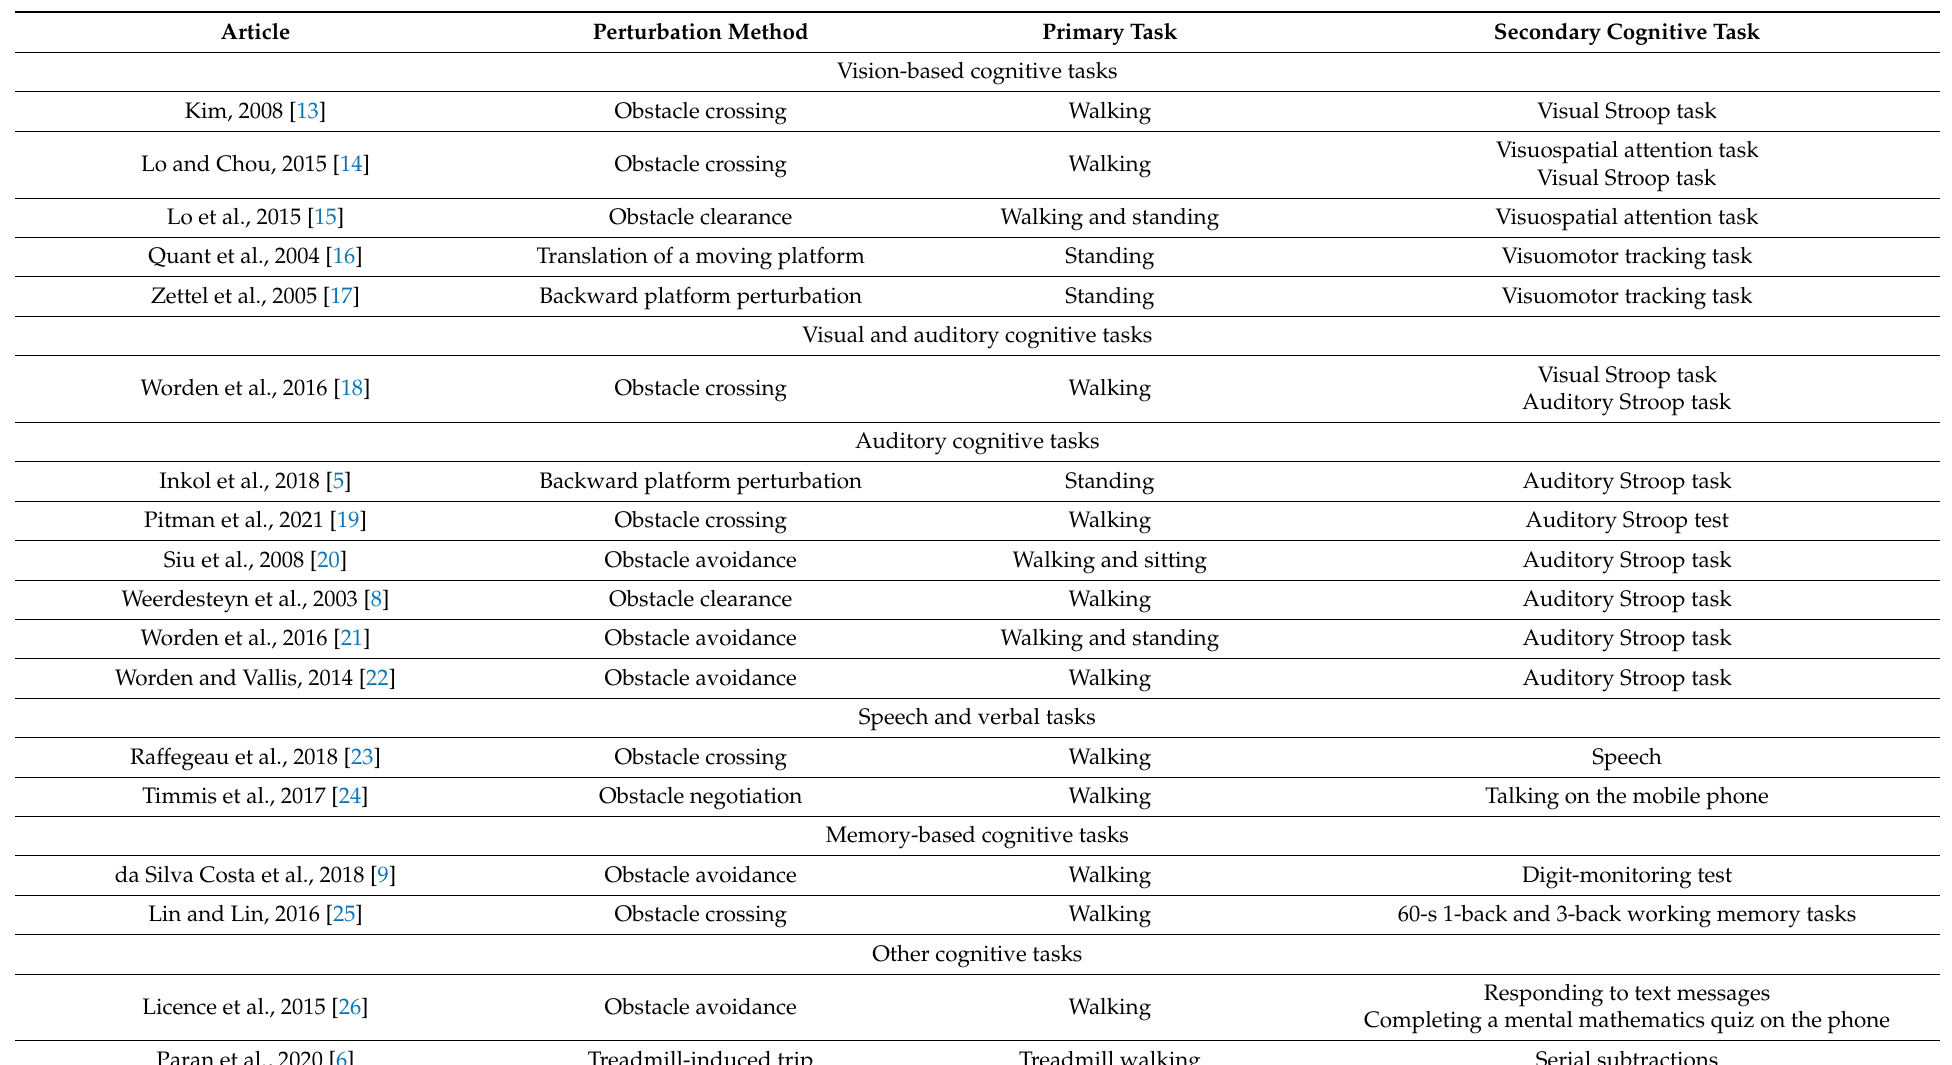
Table 1. Secondary cognitive tasks during trip recovery and obstacle